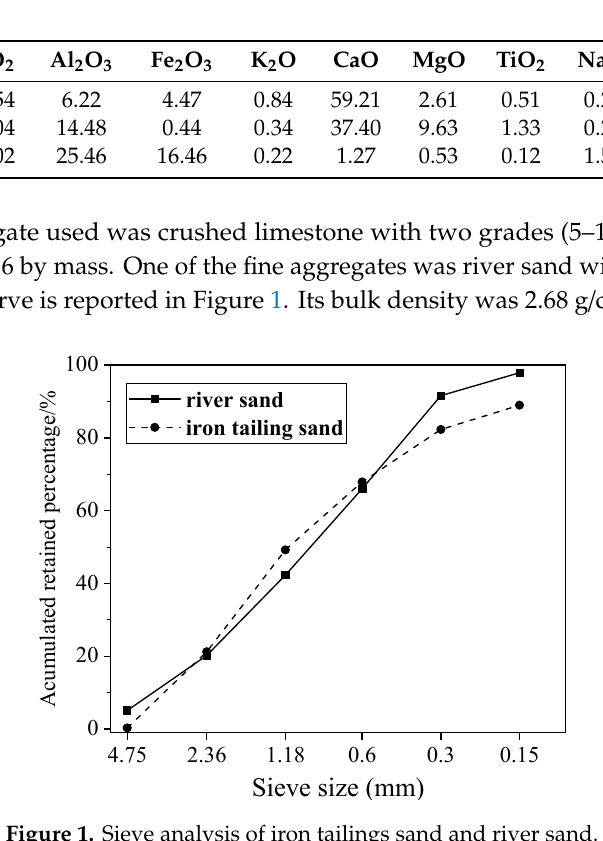
Figure 1. Sieve analysis of iron tailings sand and river sand.